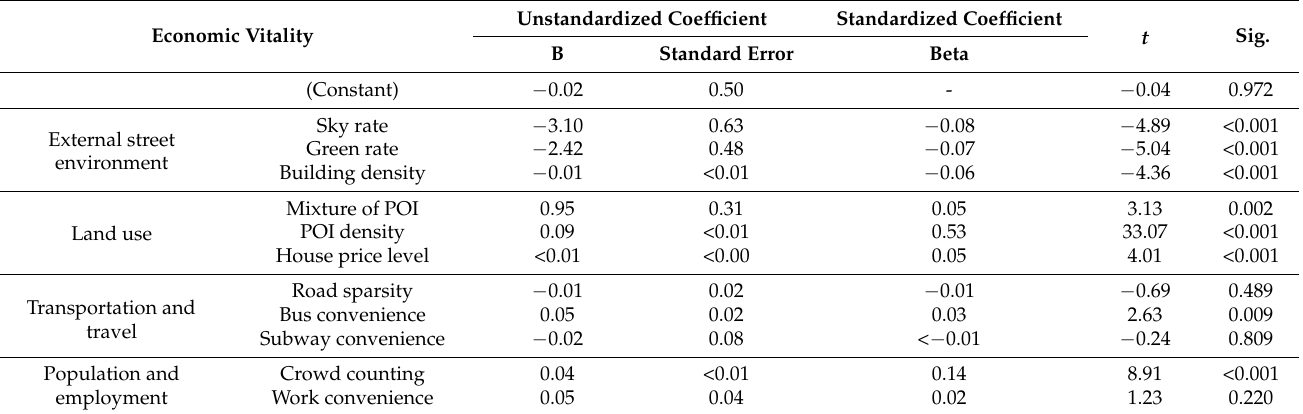
Table 7. Regression coefficient results for economic